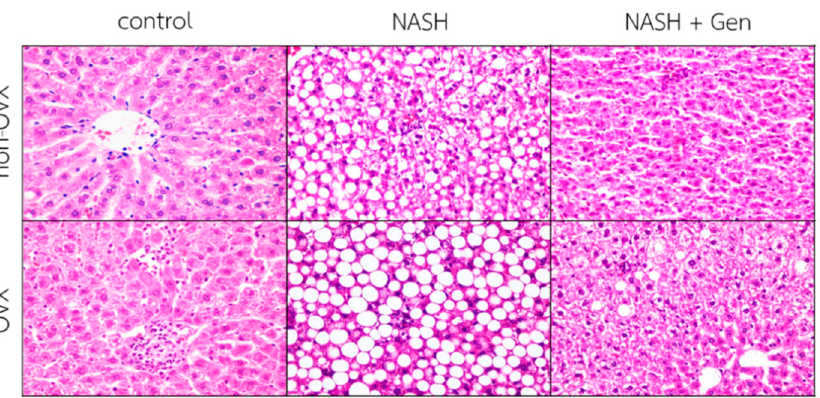
Figure 2. Hematoxylin–eosin (H&E) stain of liver sections. The degree of steatosis, lobular in- flammation, and hepatocellular ballooning were the most severe in OVX rats with NASH. Genistein improved steatosis, lobular inflammation, and hepatocellular ballooning in both non-OVX and OVX rats with NASH. The original magnification is 400x. Non-OVX: non-ovariectomized; OVX: ovariectomized; NASH: nonalcoholic steatohepatitis. Histopathological lesions were graded according to Brunt’s criteria [3] by an expe- rienced histopathologist. Steatosis, lobular inflammation, and hepatocellular ballooning scores were higher in non-OVX and OVX rats fed with a HFHF diet when compared with control groups. Noticeably, overall histological scores of NASH were higher in OVX than in non-OVX rats fed with a HFHF diet. The administration of genistein reduced the